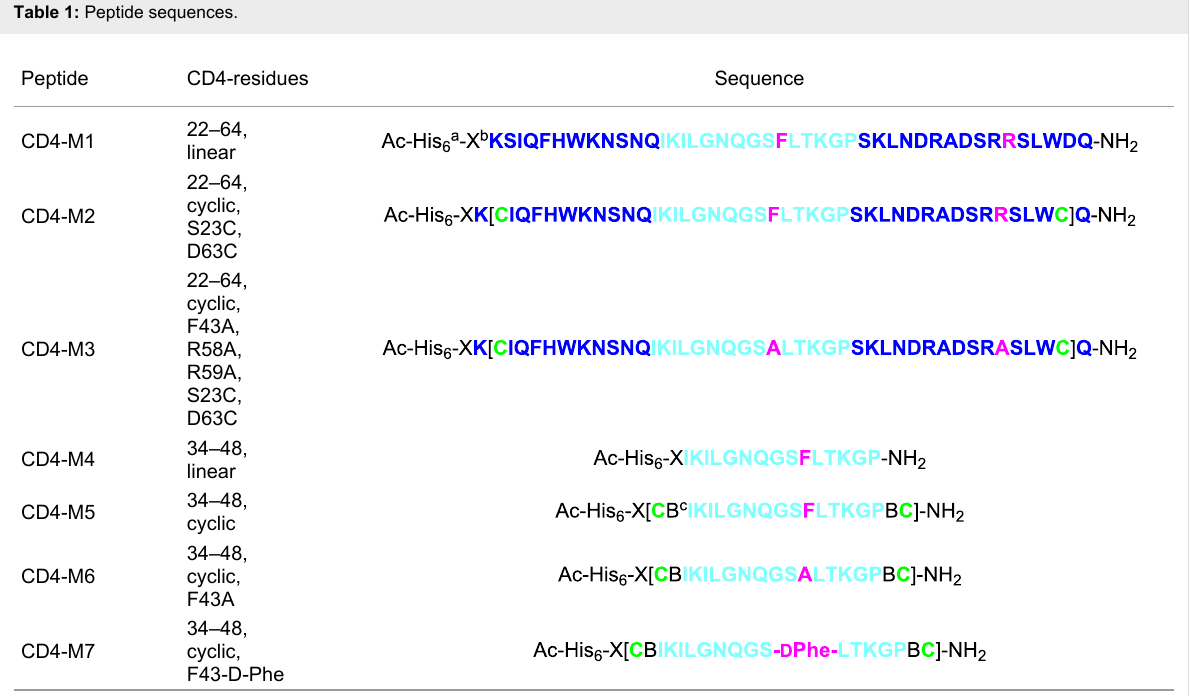
Table 1: Peptide